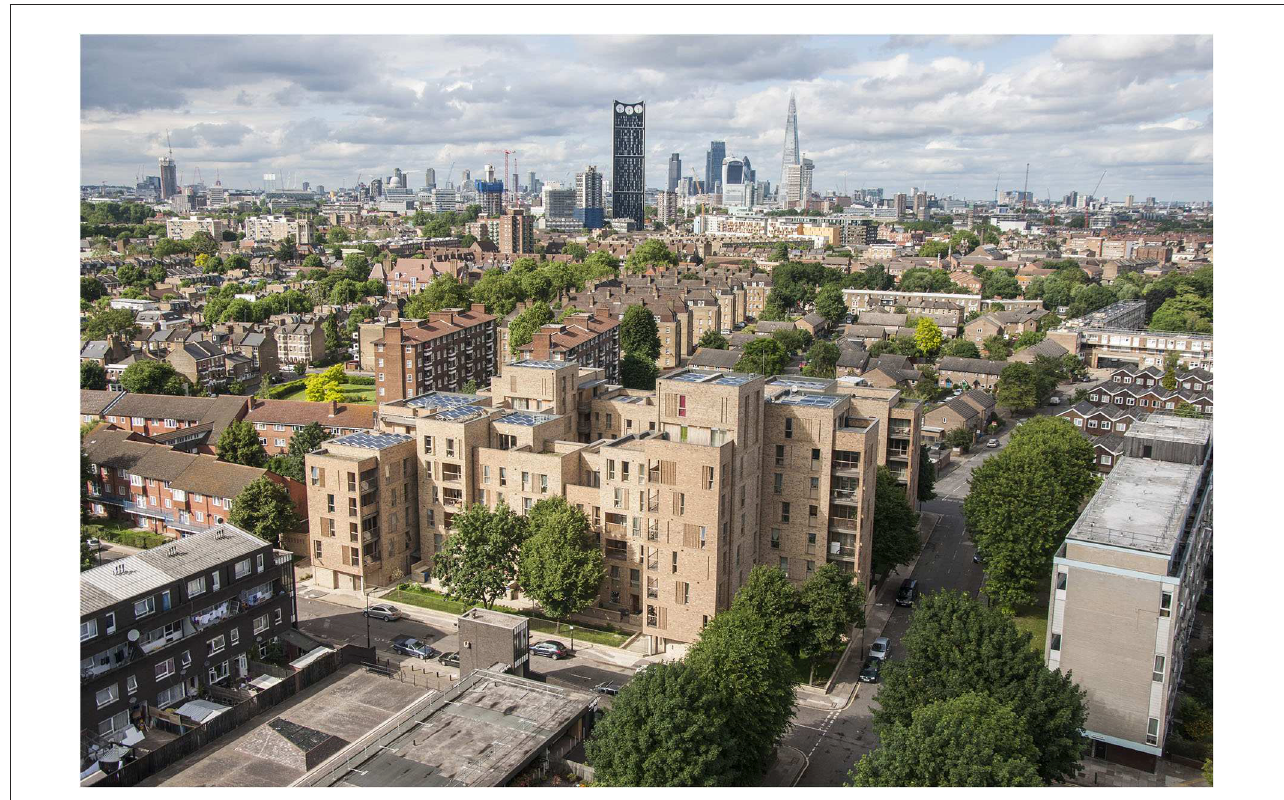
FIGURE6 Aerial view of Royal Road from the South (photo by Enrique